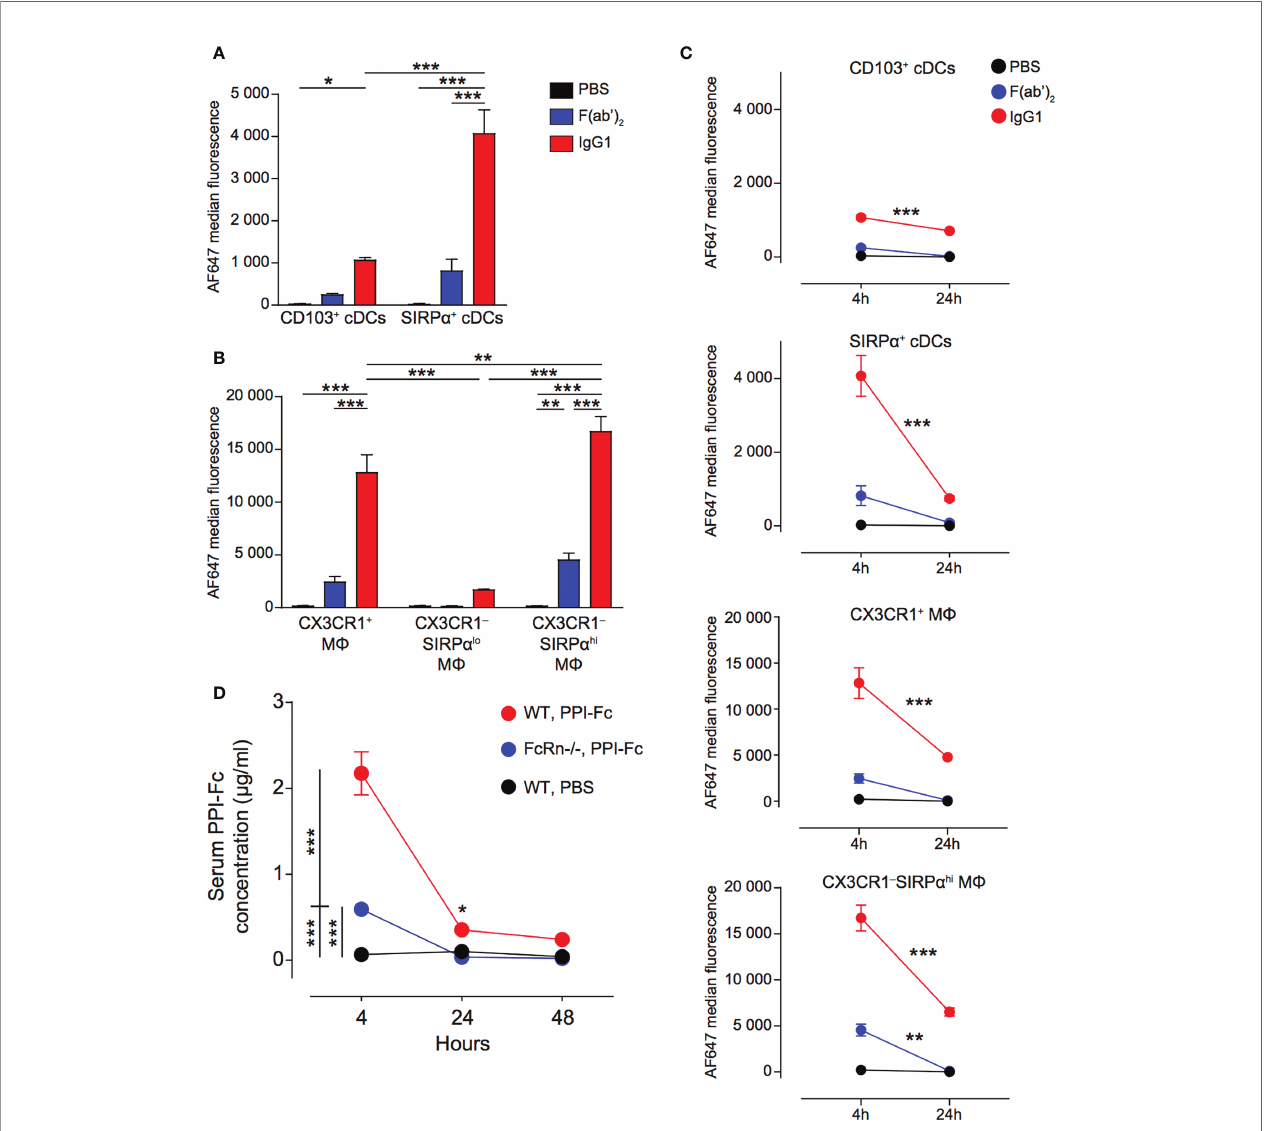
FIGURE 4 | Oral PPI-Fc reaches the spleen mainly in soluble form and is taken up locally by SIRP a + cDCs and macrophages. (A, B) Five-day-old G9C8.NOD mice were force-fed with 50 µg AF647-labeled IgG1 (red), F(ab ’ ) 2 (blue), or PBS (black). Four hours later, protein uptake (AF647 median fl uorescence) was analyzed in the spleen for the indicated APC subsets: CD103 + and SIRP a + cDCs (A) and CX3XR1 + , CX3XR1 ‒ SIRP a lo and CX3XR1 ‒ SIRP a hi macrophages (B) . (C) Comparison of the AF647 median fl uorescence at 4 and 24 h in the same APC subsets. (D) One-day-old wild-type G9C8.NOD (WT) or FcRn -/- .B6 mice were force-fed with 50 µg of PPI-Fc (or PBS in WT mice), serum was collected after 4, 24 and 48 h and PPI-Fc concentrations measured by enzyme-linked immunosorbent assays. Results are expressed as mean ± SEM from 3 mice per group (6/group in D ). * P ≤ 0.03, ** P ≤ 0.006, *** P ≤ 0.0003 by 2-way